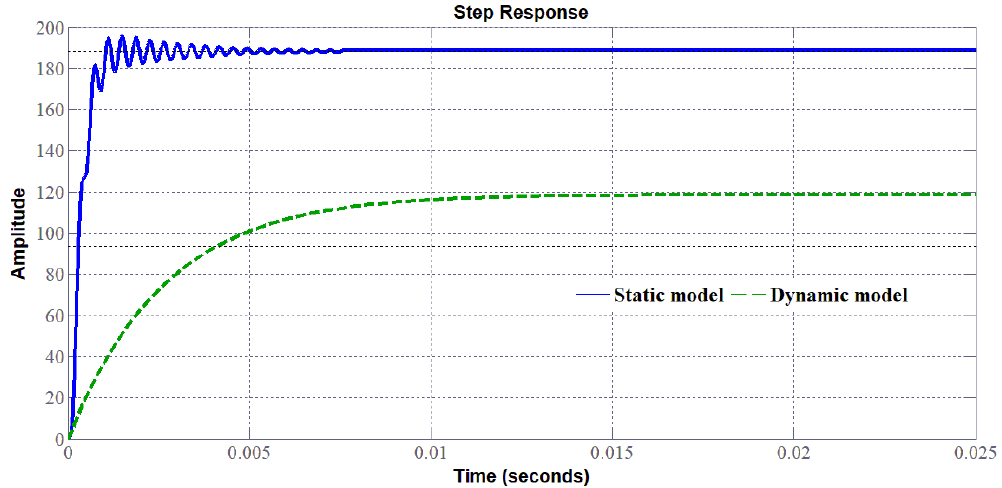
Figure 23. Step response of the SIBC either by considering a static or dynamic model.